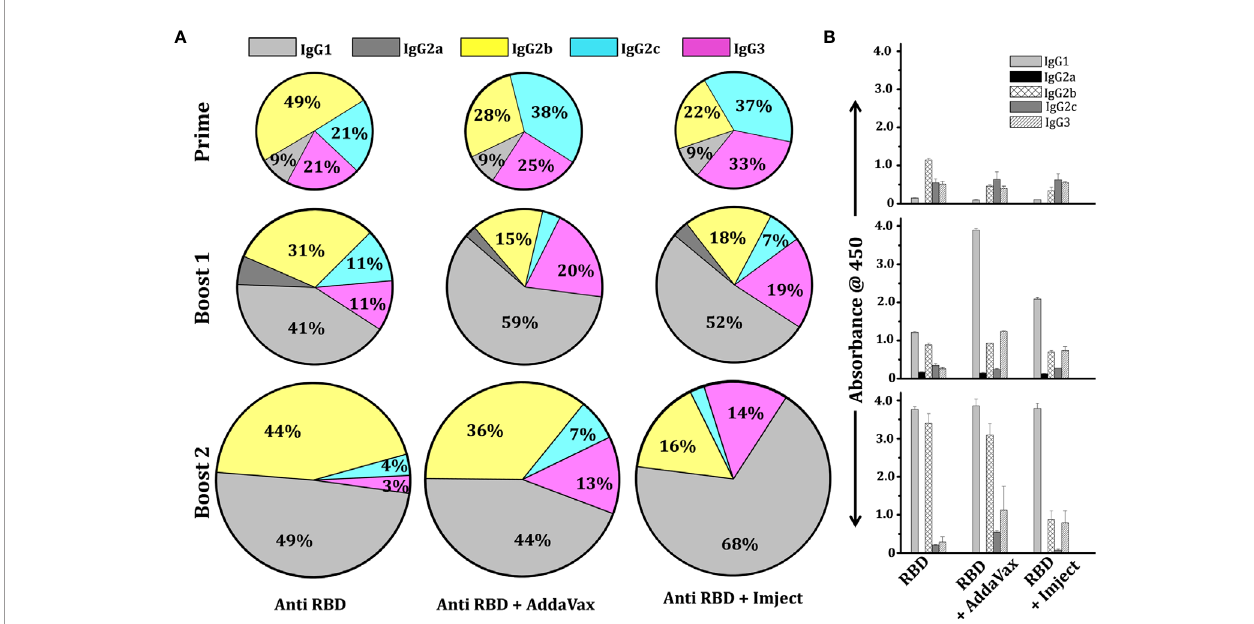
FIGURE 5 | IgG subtyping of adjuvant and non-adjuvant group. (A) Pie chart shows the mean percentile of serum IgG subtype feature of different RBD immunized groups at different time points. The colors represent the type of IgG response; grey, dark grey, yellow, cyan, and pink designate IgG1, IgG2a, IgG2b, IgG2c, and IgG3. The marked percentage in each subset designates the contribution of each subclass in the overall response. (B) Binding IgG subtype titer response showing the mean response of serum IgG subtype feature of different immunized groups at different time points with standard